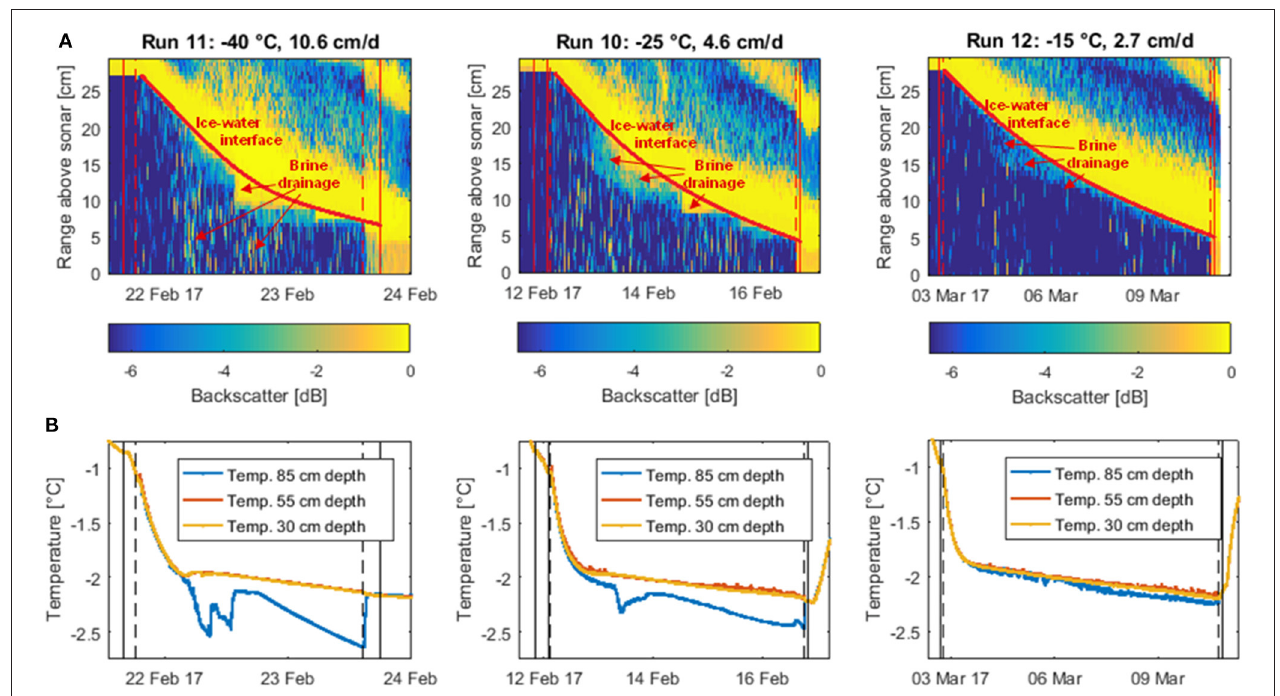
FIGURE 5 | Backscatter profiles (A) and water temperature time series (B) of the three unstirred experiments. The backscatter profiles based on data from the most sensitive Dopbeam sonar were obtained using the difference between the backscatter signal (at each point in time and distance from the sonar) and the maximum backscatter signal of that run. Thus, less negative values indicate stronger backscatter. The strong backscatter signal from the top left to the bottom right corner of each figure represents the descending ice front. The temperature curves were obtained from sensors installed at three different depths in the water, one below the ice (30cm depth, yellow), one in the middle of the water column (55cm depth, red), and one at the bottom of the tank (85cm depth, blue). Solid vertical lines indicate water (and later ice) sampling, dashed vertical lines the switching off (at the start) and on (at the end) of the stirring in the tank.